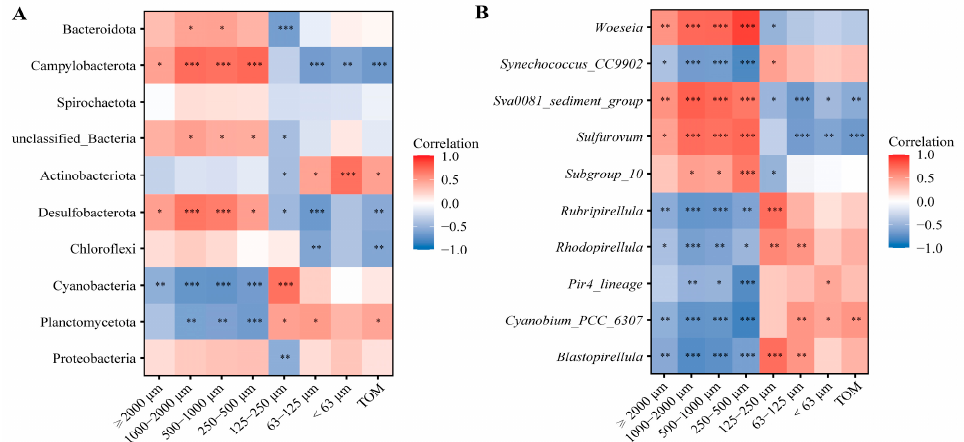
Figure 6. Heatmap of the correlations between the bacterial community composition (phylum ( A ) and genus ( B )) and grain size fraction and TOM. Pearson correlation coefficient is displayed by the color of each cell in heatmap. A significant correlation is confirmed if the p -value with Bonferroni adjusted is less than 0.05 (*), 0.01 (**), or 0.001 (***).